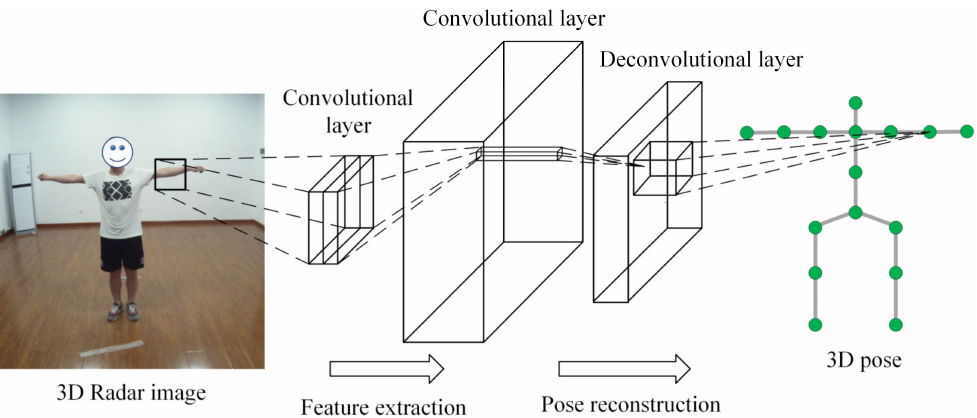
Figure 2. Schematic diagram of human pose reconstruction based on convolutional neural network